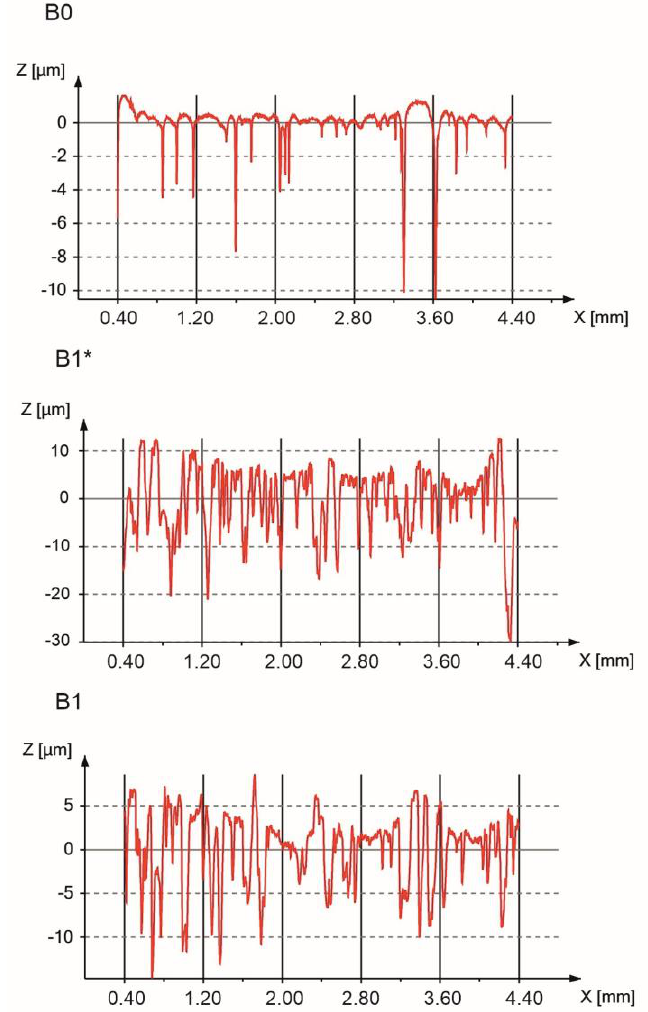
Figure 6. Roughness profiles of the bulk Ti23Zr25Nb alloy before etching (B0), after etching (B1*), and